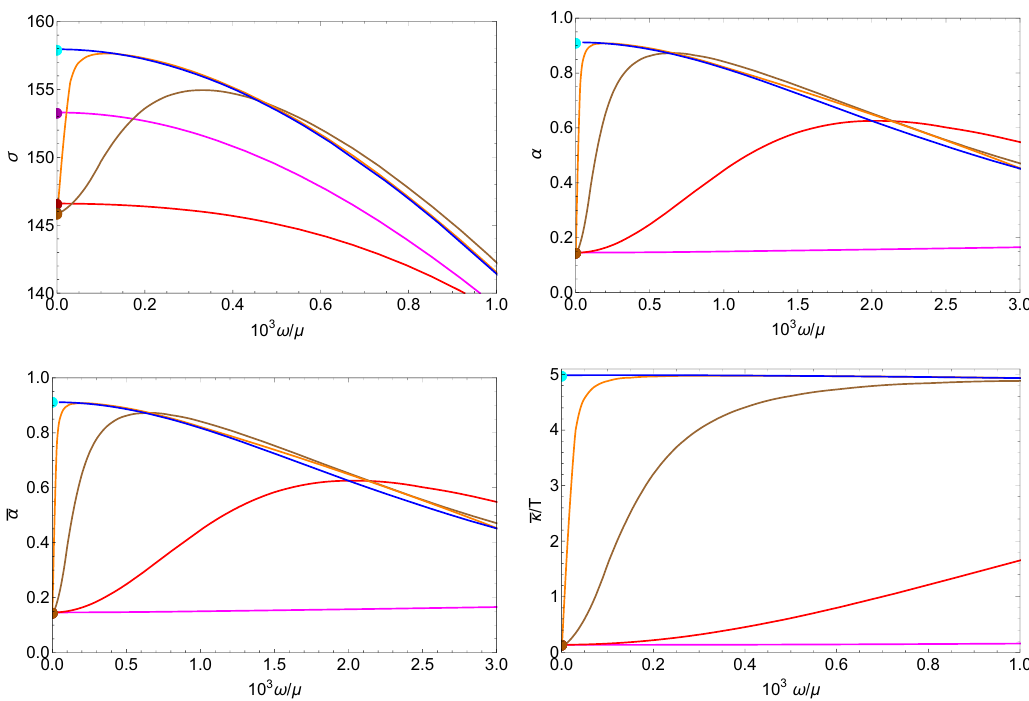
Figure 3 . Plot of the electric conductivity as a function of the frequency for T=(cid:22) = 1 = 100 and for (cid:30) s = 0 (blue), (cid:30) s =(cid:22) = 10 (cid:0) 2 (magenta), (cid:30) s =(cid:22) = 10 (cid:0) 3 (red) and (cid:30) s =(cid:22) = 10 (cid:0) 4 (brown) and (cid:30) s =(cid:22) = 10 (cid:0) 5